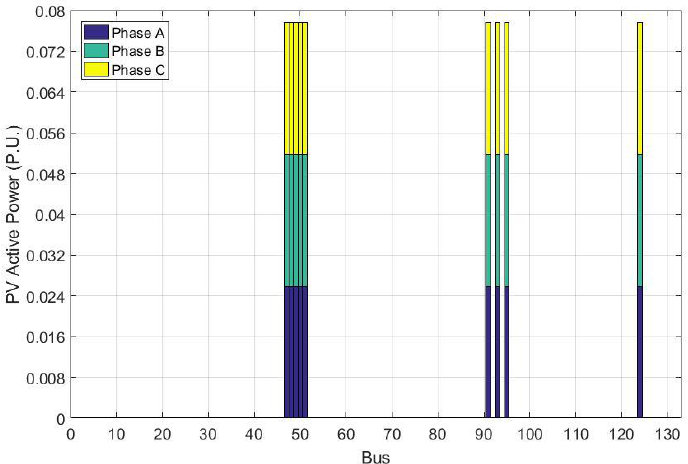
Figure 5. IEEE 123-Bus Maximum PV Active Power, 70% PV Penetration.